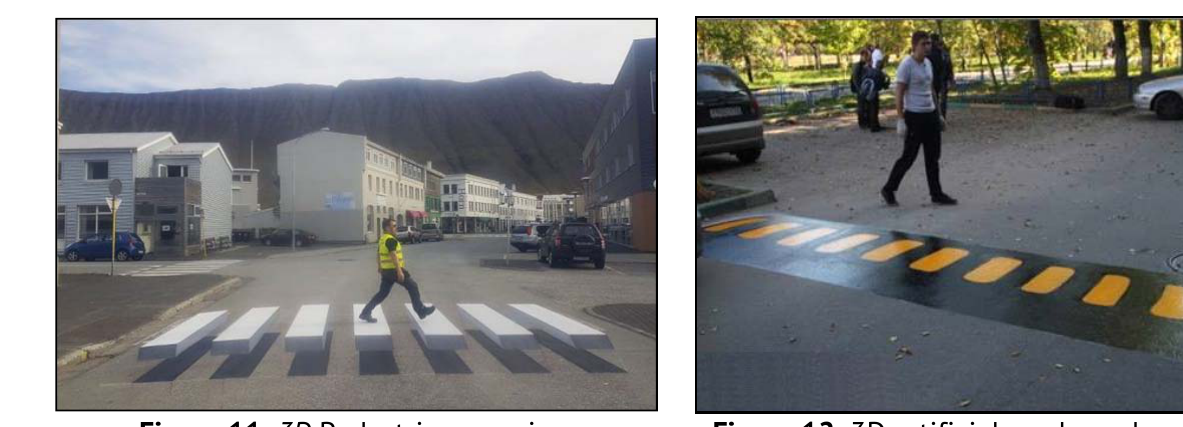
Figure 11. 3D Pedestrian crossing. Figure 12. 3D artificial road